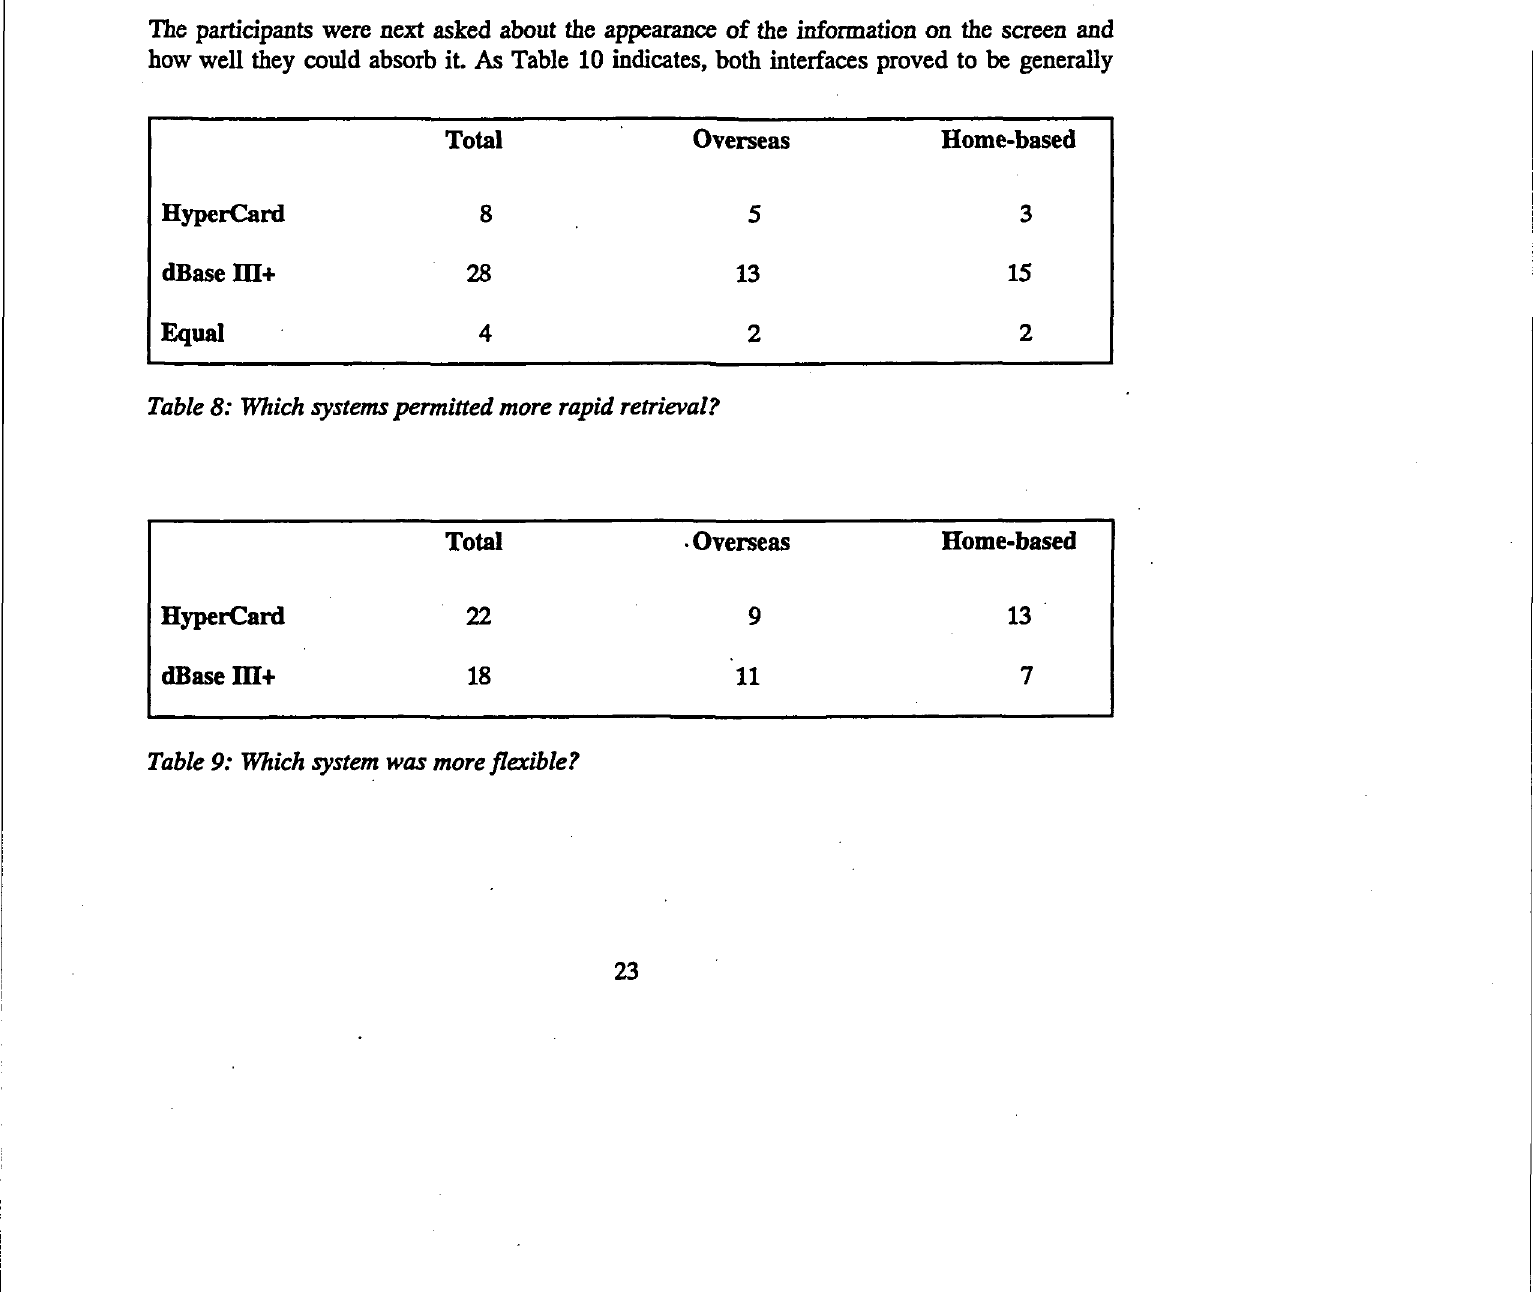
Table 9: Which system was more